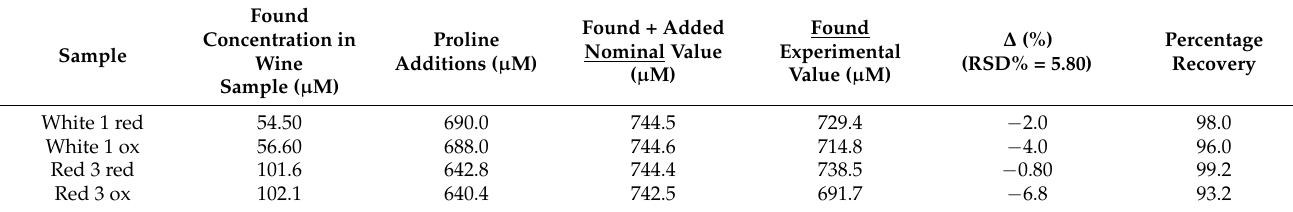
Table 5. Experimental percentage recovery for proline addition ( µ M) in red and white wines, using the standard addition method. The reported found values are the mean of three determinations. The concentrations reported in the second column provide the concentrations of samples after dilutions introduced by applying the format described in Section 2.4.4, therefore they do not represent the real found values of not diluted wine samples, such as those listed in Table 4, where concentrations are expressed in mg L − 1